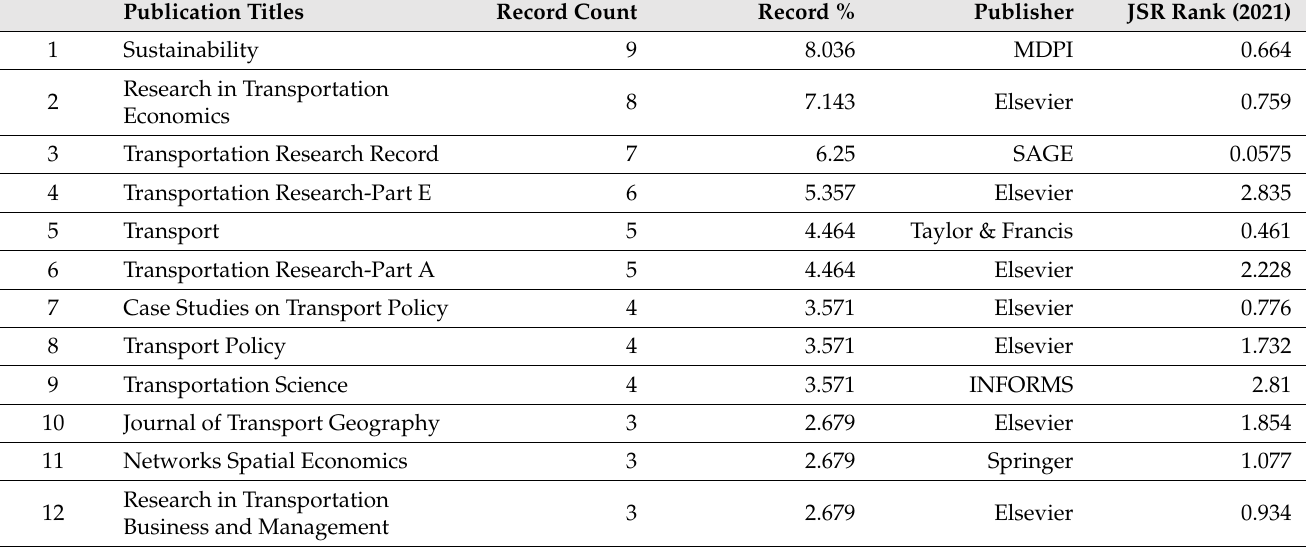
Table 5. Top-publishing journals out of 56.